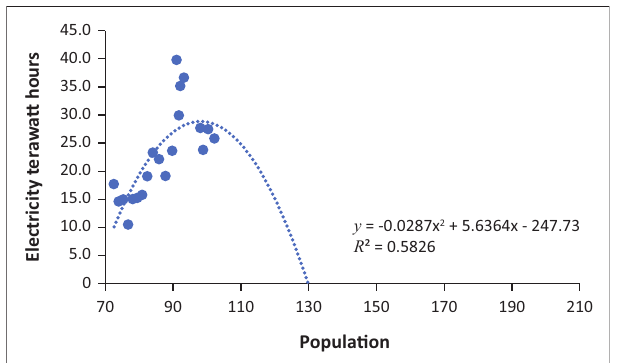
FIGURE 3: The fitted line of the electricity generated from oil.